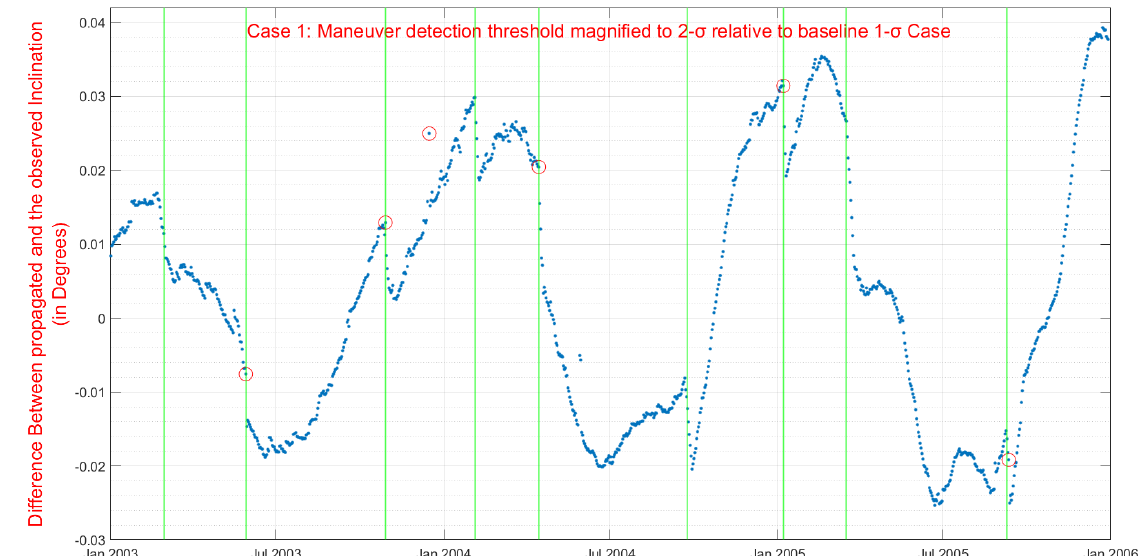
Figure 4. Case 1: Maneuver detection threshold magnified to 2-sigma relative to baseline 1-sigma case. Vertical green lines represent the maneuvers and the red circles represent potential maneuvers detected by this method.